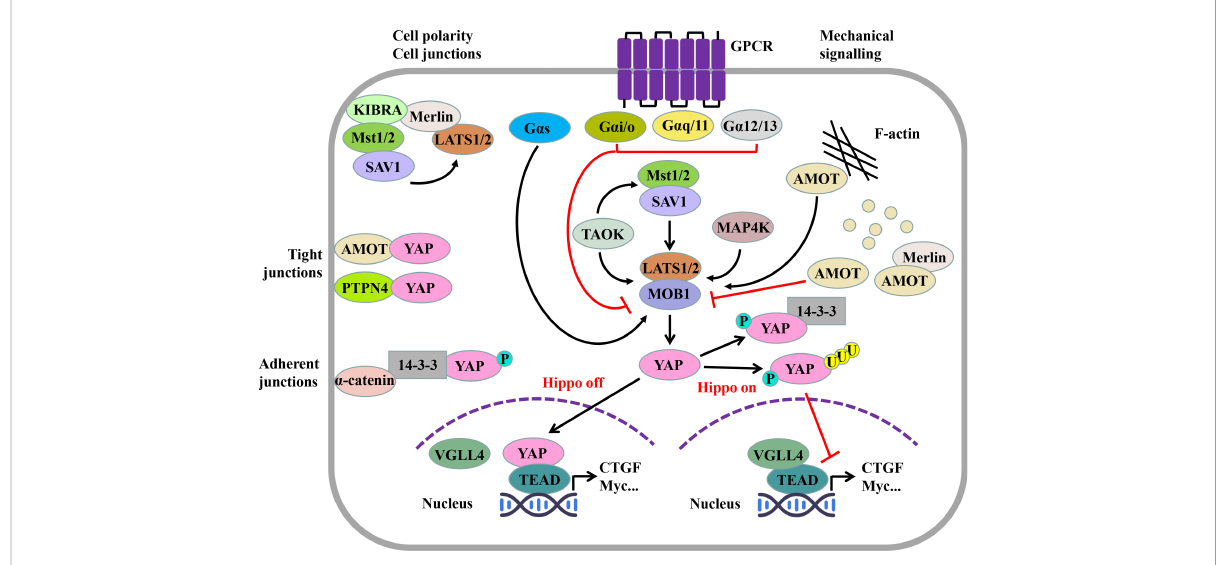
FIGURE 1 Hippo pathway and its regulatory factors. The Hippo pathway consists of serine/threonine kinases MST1/2 and LATS1/2, regulatory molecules SAV1 and MOB1, and effector molecules YAP. When the Hippo pathway is not activated, YAP, as a transcriptional coactivator, can enter the nucleus and combine with TEAD competitively, thus inducing the transcription of target genes. When the Hippo pathway is activated, activated MST1/2 can phosphorylate LATS1/2, and then, YAP is further phosphorylated. Phosphorylated YAP can be captured by 14-3-3 proteins in the cytoplasm or degraded through the SCF b -TRCP E3 ligase-mediated ubiquitin proteasome pathway. The Hippo pathway is regulated by several upstream signals. Cell connectivity and cell polarity components, such as KIBRA, AMOT, PTPN4, and a -catenin, are a classical upstream regulator of the Hippo pathway; the effect of the GPCR on the Hippo pathway depends on its a subunit type; and mechanical cues can regulate the Hippo pathway by affecting LATS1/2 activity through the cytoskeleton. (MST1/2, mammalian Ste20-like kinase 1/2; SAV1, Salvador family WW domain-containing protein 1; LATS1/2, large tumor suppressor factor 1/2; MOB1, MOB kinase activating factor 1; YAP, Yes-associated protein; TAOK, TAO kinase; MAP4K, mitogen-activated protein kinase kinase kinase kinase; TEAD, TEA domain transcription factor family;